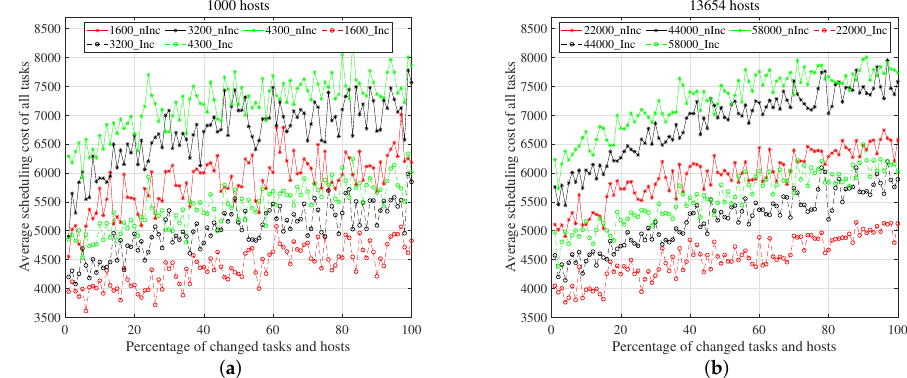
Figure 10. Average scheduling cost of all tasks. ( a ) 1000 hosts. ( b ) 13,654